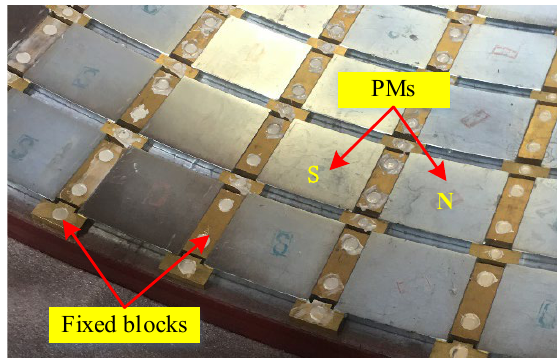
Figure 2. Configuration of the rotor.